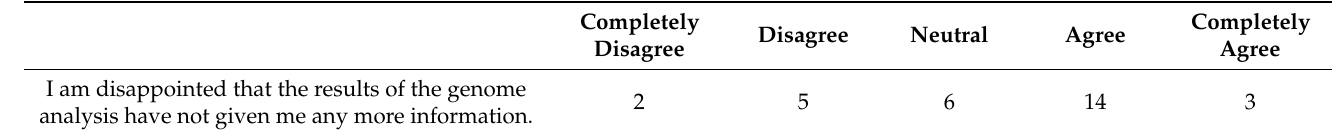
Table 7. Respondents’ attitudes towards genome analysis after receiving individual WGS results (post, n = 30). Completely Disagree Neutral Agree Disagree 2 5 6 14